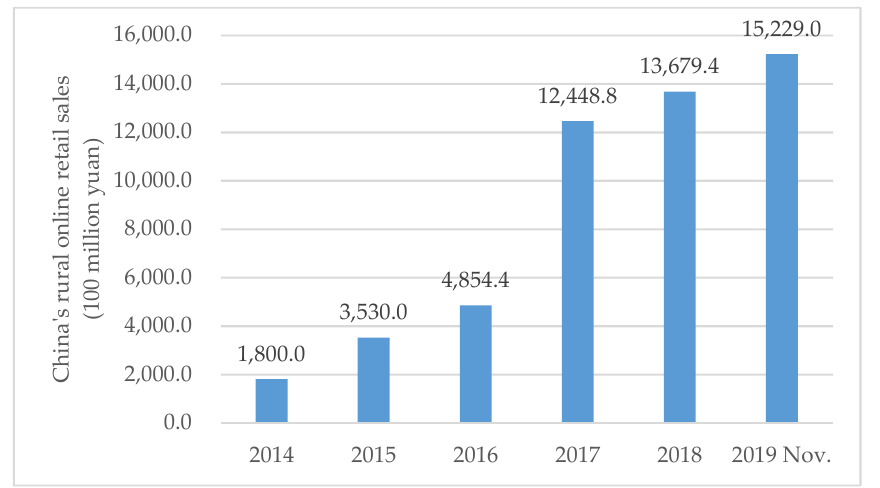
Figure 1. China’s rural online retail sales from 2014 to November 2019 (Data source: China rural e-commerce market forecast and investment planning analysis report released by Chinese Qianzhan industry research institute.).